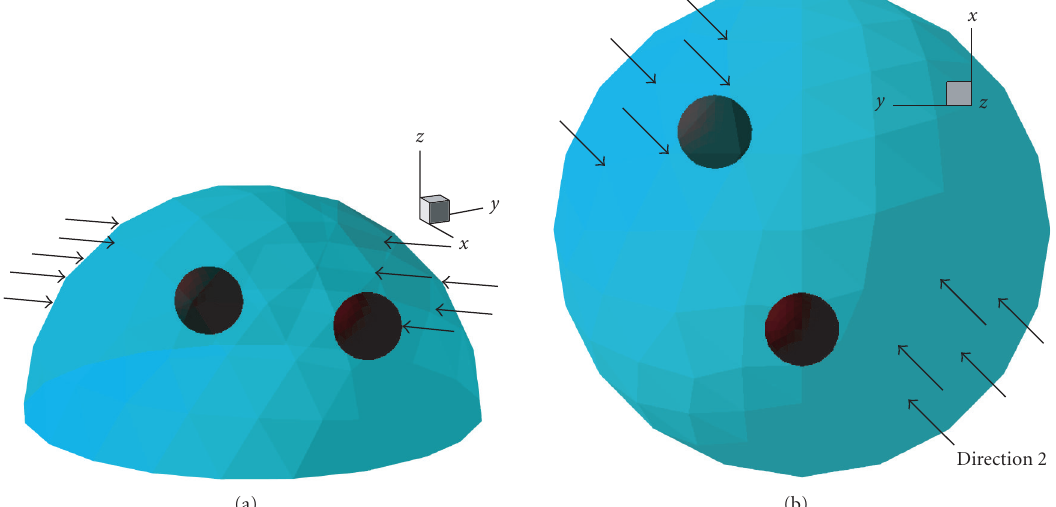
Figure 4: Loading 2: compression nodal force applied on the surface of Phantom II. (a) 3D view; (b) x - y plane view to show direction